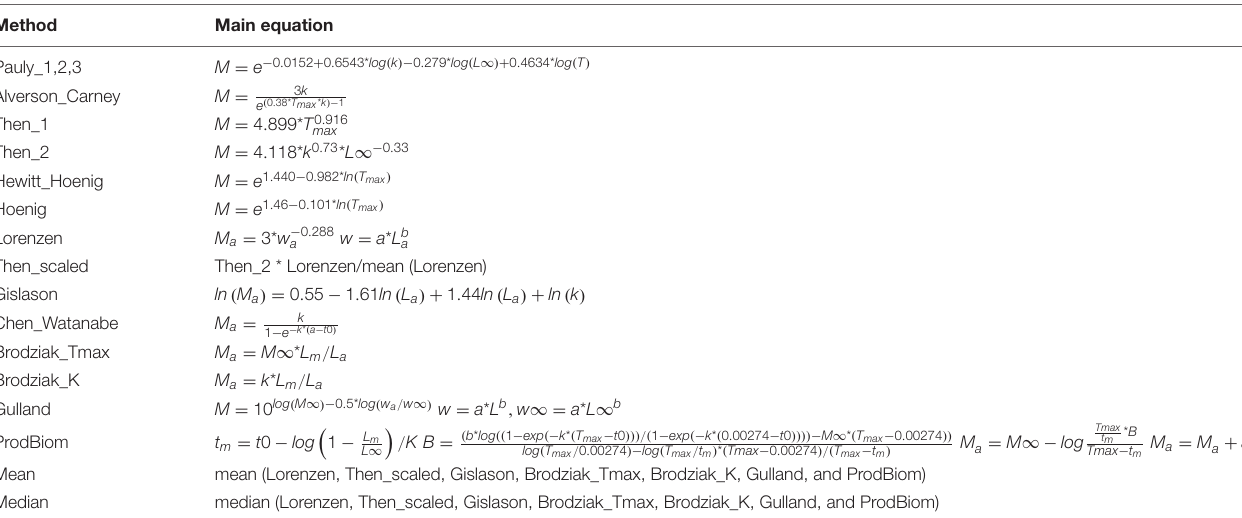
TABLE 2 | Methods and equations used to estimate M as a constant value or as an age-dependent vector. Method Main